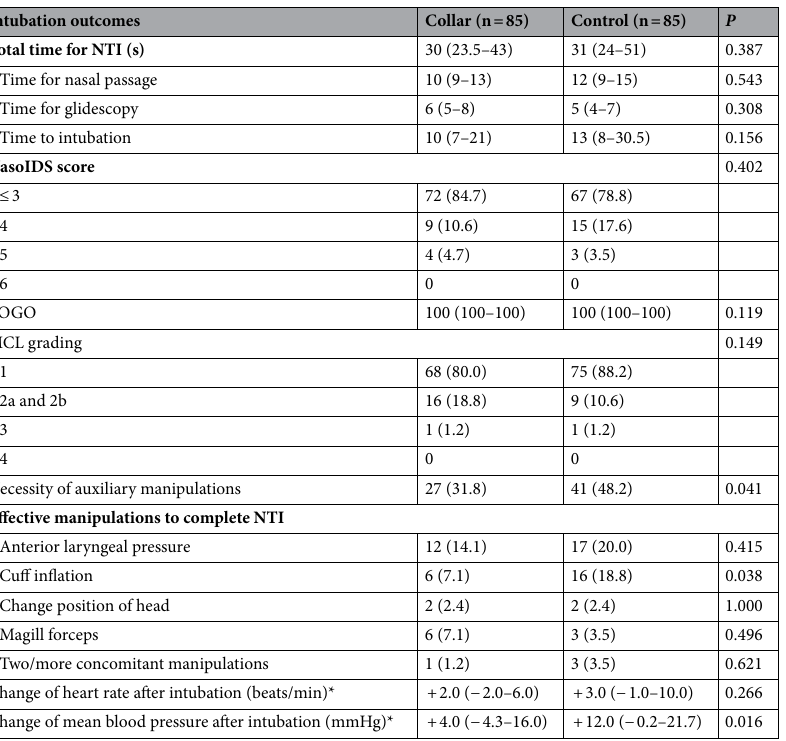
Table 2. Intubation outcomes. Data are presented as median (interquartile range) or number (%). NTI nasotracheal intubation, NasoIDS nasotracheal intubation difficulty scale, POGO percentage of glottic opening, MCL modified Cormack–Lehane, Nasal preparation tracheal tube passing through the nose to the oropharynx, glidescopy from insertion of the GlideSope to visualization of the glottis, Intubation tracheal tube advancing from the oropharynx into the trachea. *2 min after tracheal